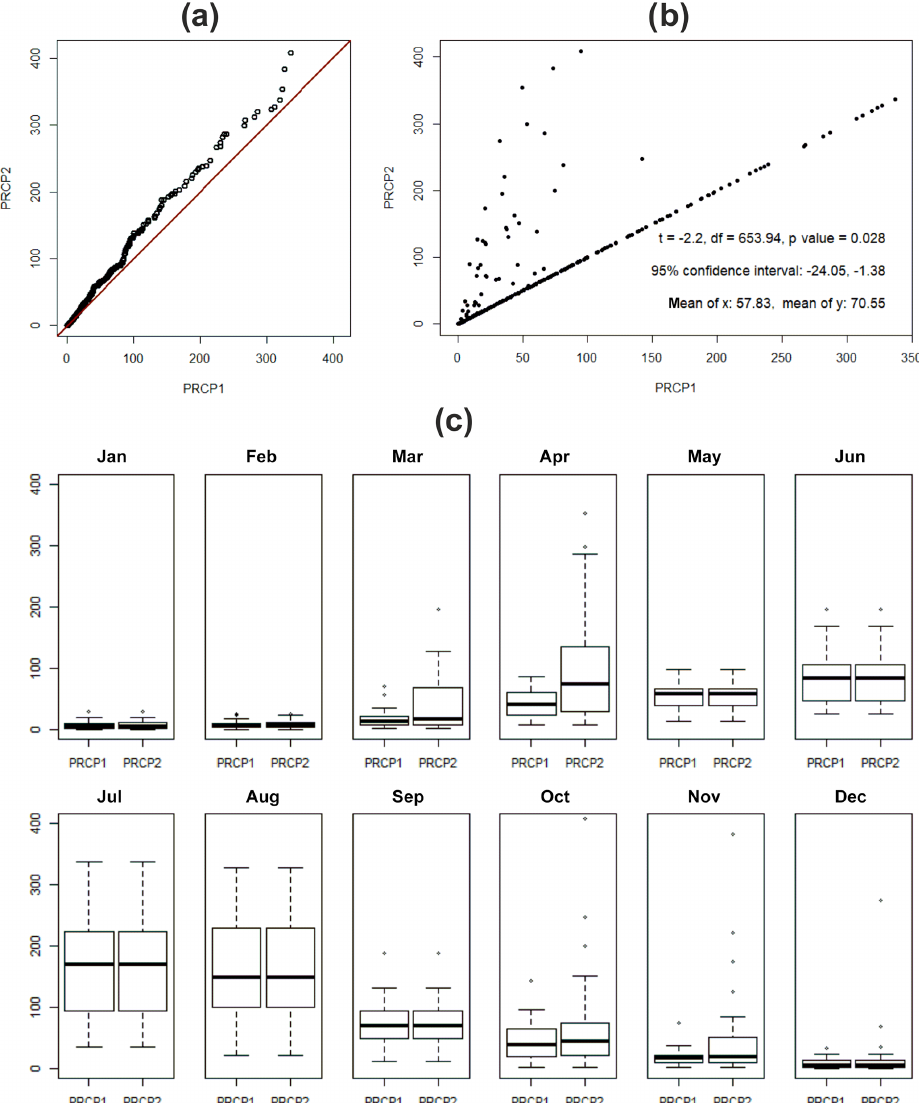
Figure 2. (a) Q–Q plot of the two coeval precipitation series (mm) data sources ( p value 0.028); (b) monthly precipitation comparison of two datasets (significance analysis of precipitation from 1961 to 1988); (c) monthly precipitation distribution and outliers for January